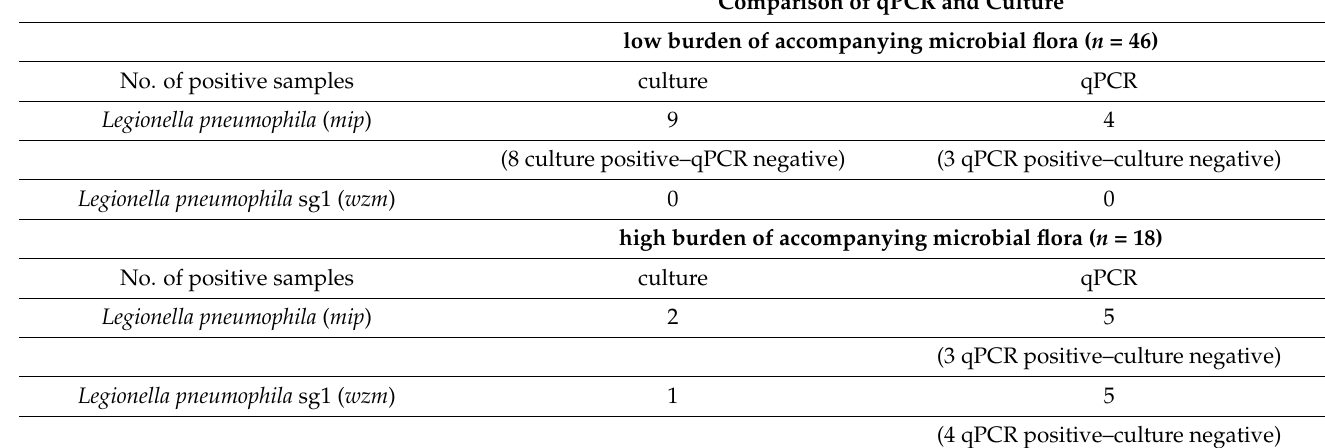
Table 3. Positive samples with low and high burden of accompanying microbial flora from qPCR and culture for L. pneumophila and L. pneumophila sg 1, established from the L. pneumophila qPCR for the mip gene and the L. pneumophila sg 1 qPCR for the wzm